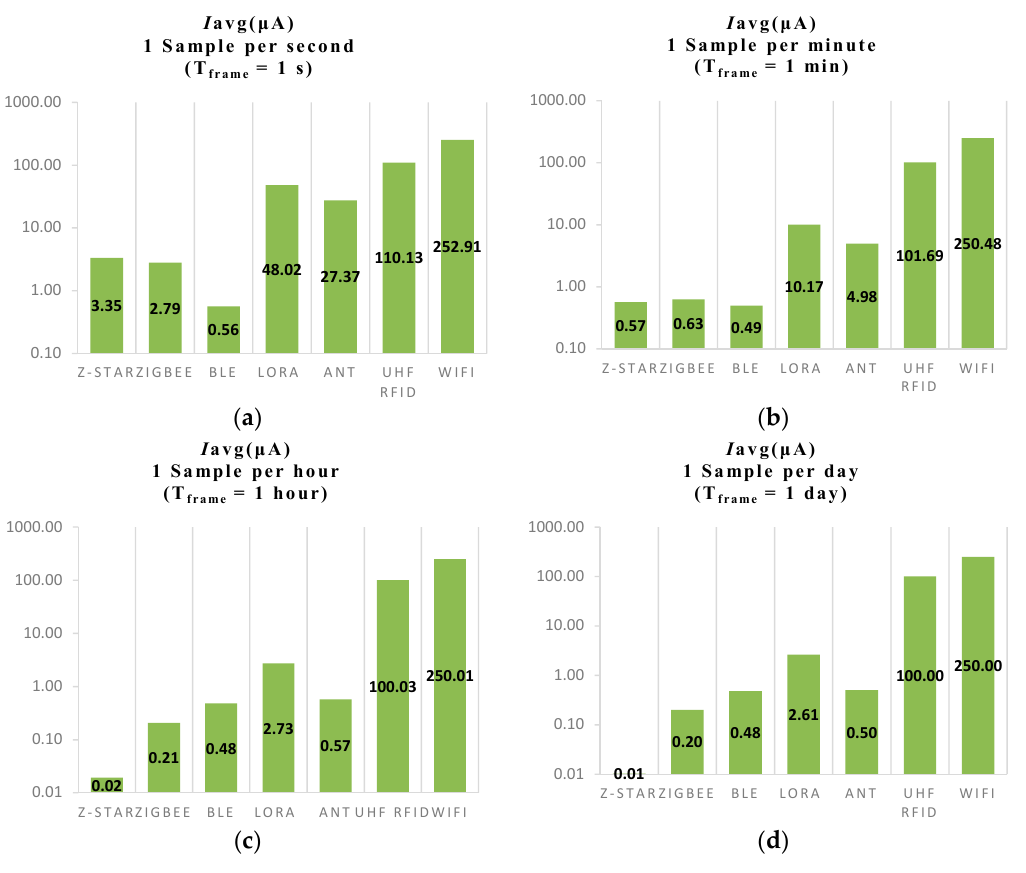
Figure 4. Histograms of the average current consumption: ( a ) T frame = 1 s; ( b ) T frame = 1 min; ( c ) T frame = 1 h; ( d ) T frame = 1 day.